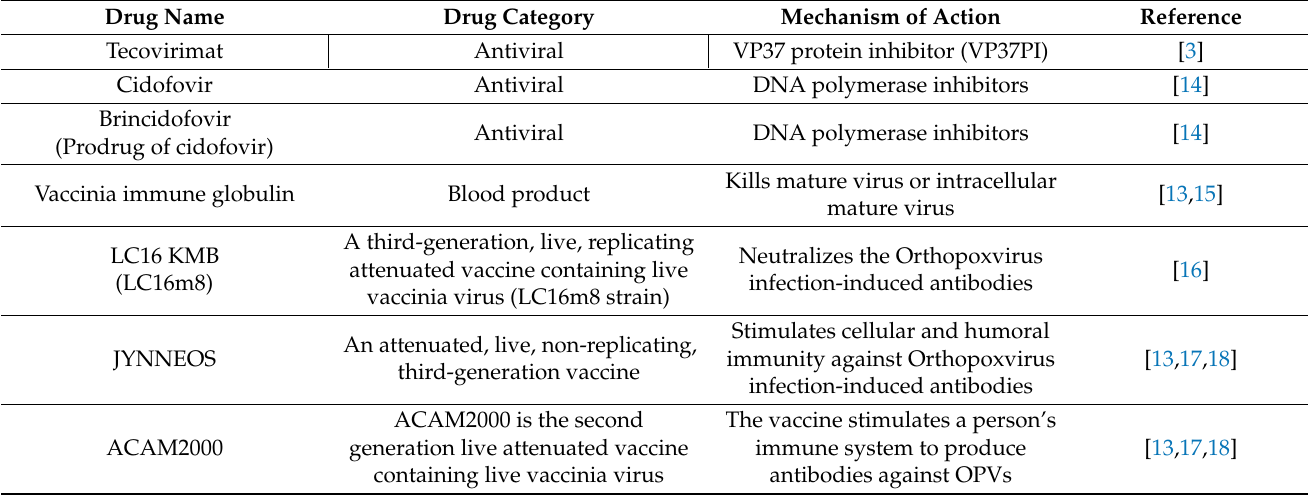
Table 2. Treatment and prevention of Mpox.